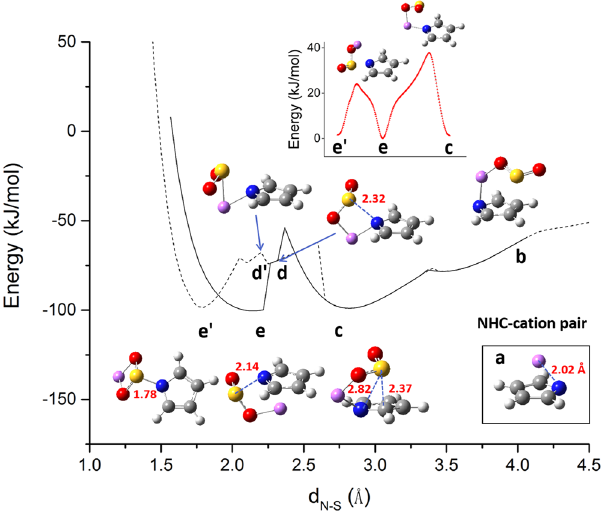
Figure 2. PES of Li + -assisted reaction between pyrrolide 1 and SO 2 . Solid line stands for the absorption process and dotted line stands for the desorption process. Key structures on the PES’ are labelled and plotted. The energy reference point is chosen when the (NHC-Li + ) complex and SO 2 are at an infinite distance. Bottom right inset: the 1 -Li + complex. Top inset: transition energetics and transition states from e ′ to e and from e to c ,